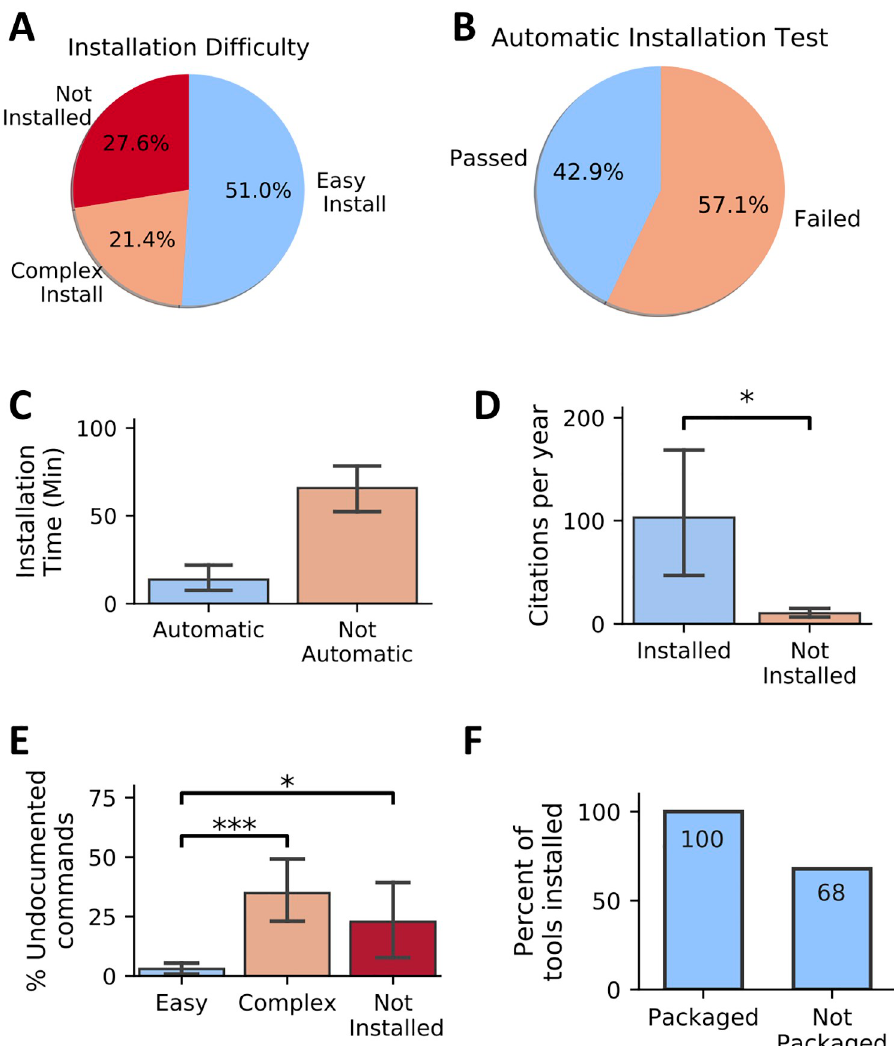
Fig 2. Installability of 98 randomly selected published software tools across 22 life-science journals over a span of 15 years. Error bars, where present, indicate SEM. (A) Pie chart showing the percentage of tools with various levels of installability. (B) A pie chart showing the proportion of evaluated tools that required no deviation from the documented installation procedure. (C) Tools that require no manual intervention (pass automatic installation test) exhibit decreased installation time. (D) Tools installed exhibit increased citation per year compared with tools that were not installed (Kruskal–Wallis, p -value = 0.035). (E) Tools that are easy to install include a decreased portion of undocumented commands (Not Installed versus Easy Install: Mann–Whitney U test, p -value = 0.01, Easy Install versus Complex Install: Mann–Whitney U test, p -value = 8.3 × 10 − 8 ). (F) Tools available in well-maintained package managers such as Bioconda were always installable, whereas tools not shipped via package managers were prone to problems in 32% of the studied cases. SEM, standard error of the mean.